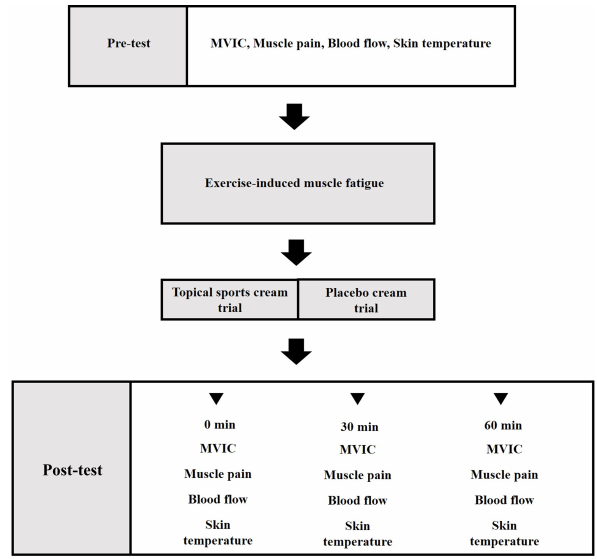
Fig. 1. Experimental procedure. MVIC, maximum voluntary isometric